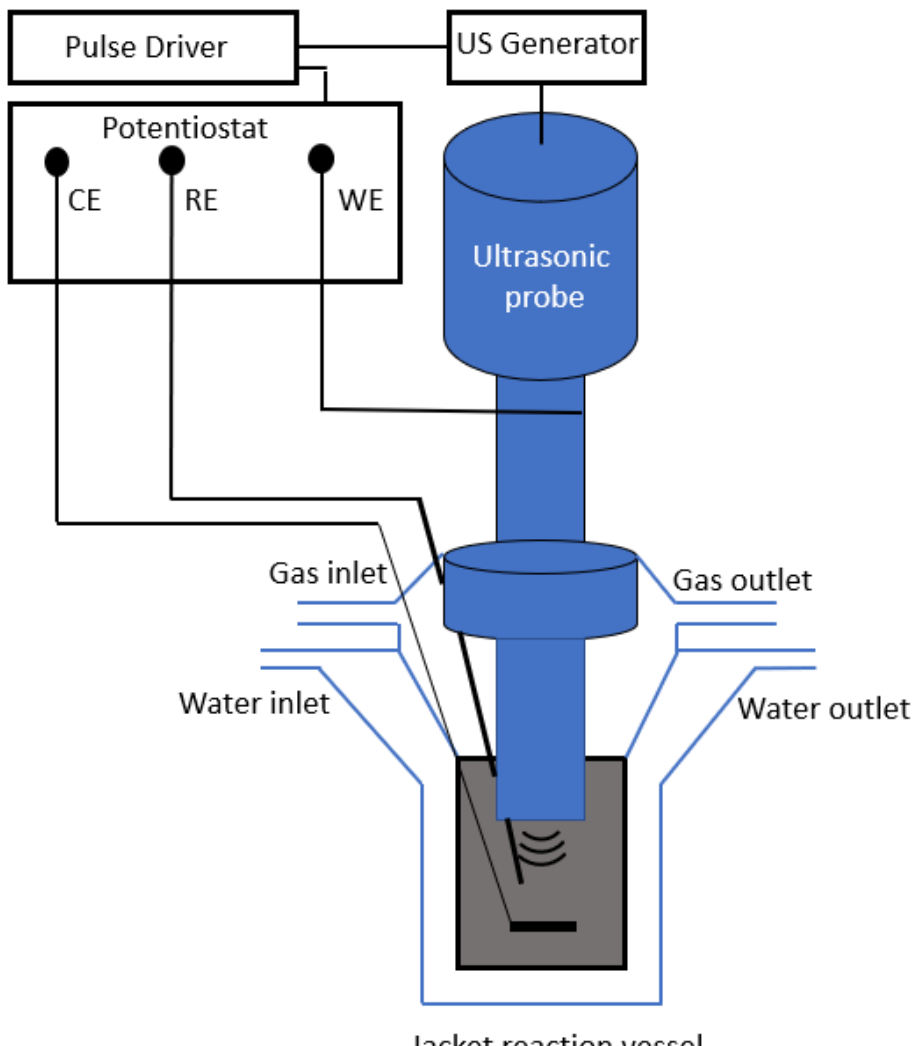
Figure 6. Sonoelectrochemical set-up for the production of PEMFC and proton exchange membrane water electrolyzer (PEMWE) catalysts.